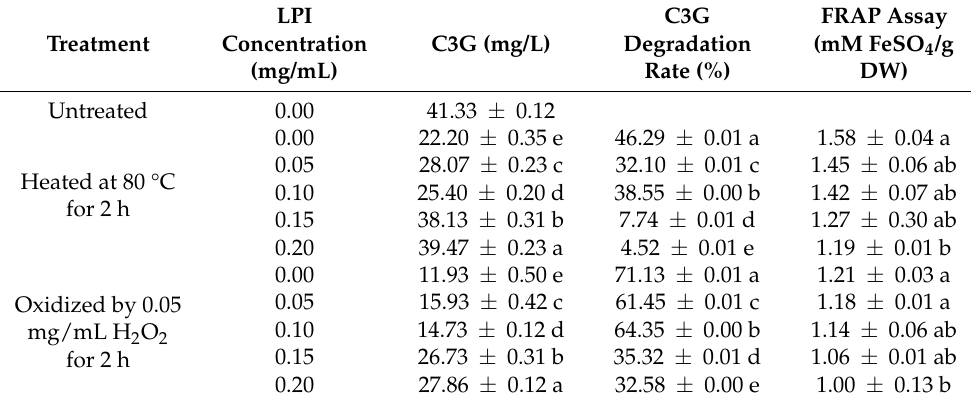
Table 3. Effects of LPI on stability and antioxidant activity of LPI-C3G complexes. FRAP Assay LPI C3G (mM FeSO 4 /g Treatment Concentration C3G (mg/L) Degradation DW) (mg/mL) Rate (%) Untreated 0.00 41.33 ± 0.12 0.00 22.20 ± 0.35 e 46.29 ± 0.01 a 1.58 ± 0.04 a 0.05 28.07 ± 0.23 c 32.10 ± 0.01 c 1.45 ± 0.06 ab Heated at 80 °C 0.10 25.40 ± 0.20 d 38.55 ± 0.00 b 1.42 ± 0.07 ab for 2 h 0.15 38.13 ± 0.31 b 7.74 ± 0.01 d 1.27 ± 0.30 ab 0.20 39.47 ± 0.23 a 4.52 ± 0.01 e 1.19 ± 0.01 b 0.00 11.93 ± 0.50 e 71.13 ± 0.01 a 1.21 ± 0.03 a 0.05 15.93 ± 0.42 c 61.45 ± 0.01 c 1.18 ± 0.01 a Oxidized by 0.05 0.10 14.73 ± 0.12 d 64.35 ± 0.00 b 1.14 ± 0.06 ab mg/mL H 2 O 2 0.15 26.73 ± 0.31 b 35.32 ± 0.01 d 1.06 ± 0.01 ab for 2 h 0.20 27.86 ± 0.12 a 32.58 ± 0.00 e 1.00 ± 0.13